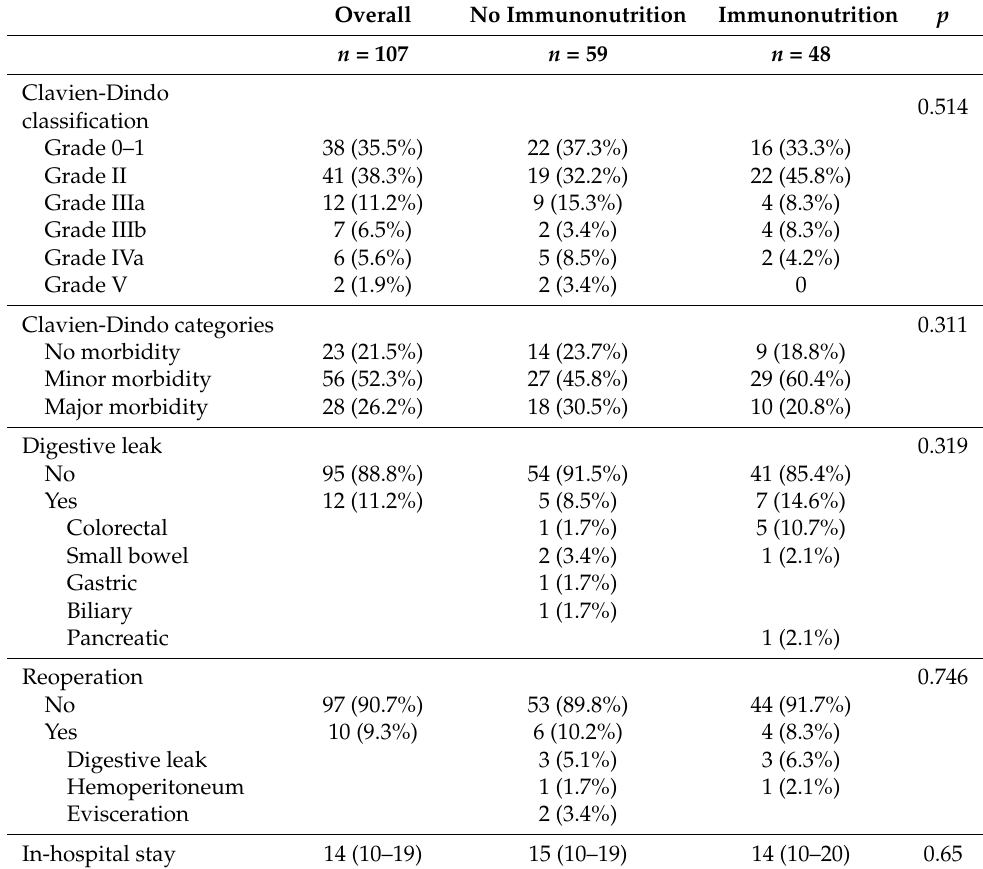
Table 2. Postoperative